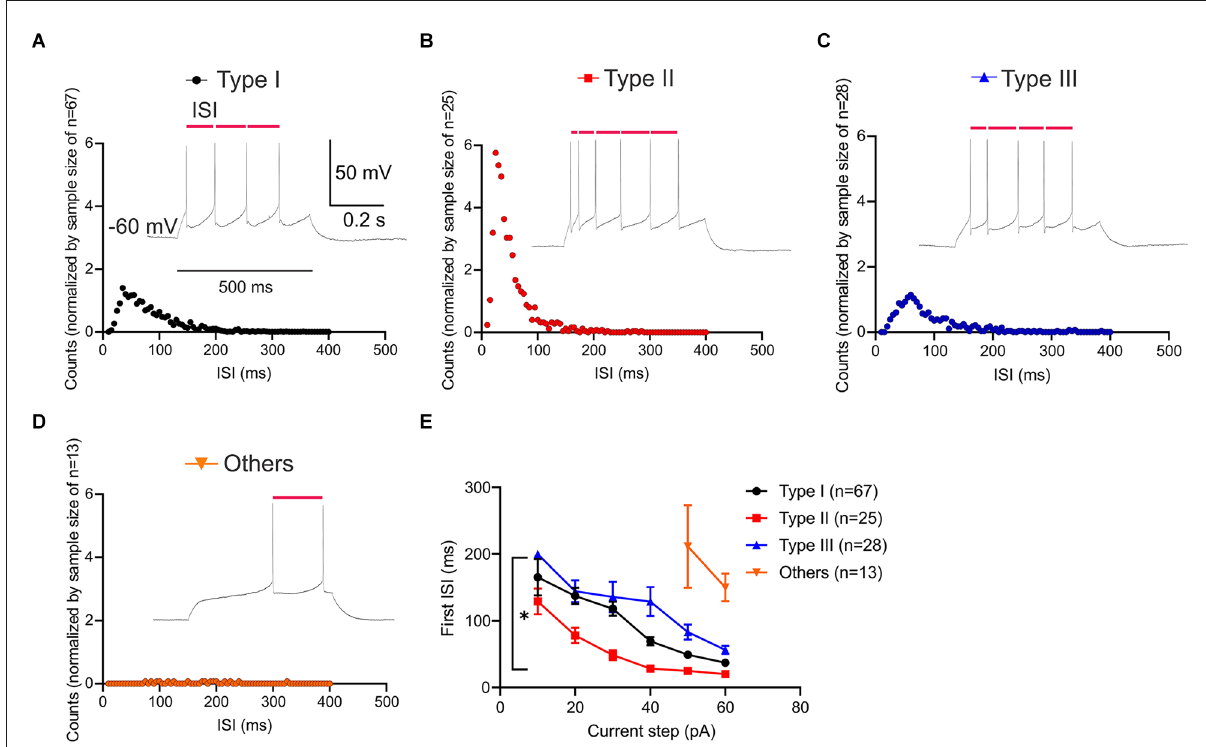
FIGURE5 Interspike interval (ISI; ms) patterns of VTA projecting BNST neurons. (A–D) Histogram of ISI and sample traces of each neuronal type at 60 pA current step for 500 ms (inset). Scale bar: 50 mV, 0.2 s. The horizontal axis is for the time between each spike and the vertical axis is for the number of intervals at an ISI value normalized by sample size. (E) First ISI comparison among groups. Type II neurons have significantly higher number of shorter ISI, as compared to Type I and Type III (adjusted P = 0.0003, vs. Type I; adjusted P = 0.0033, vs. Type III at 20 pA). ∗ P < 0.05.